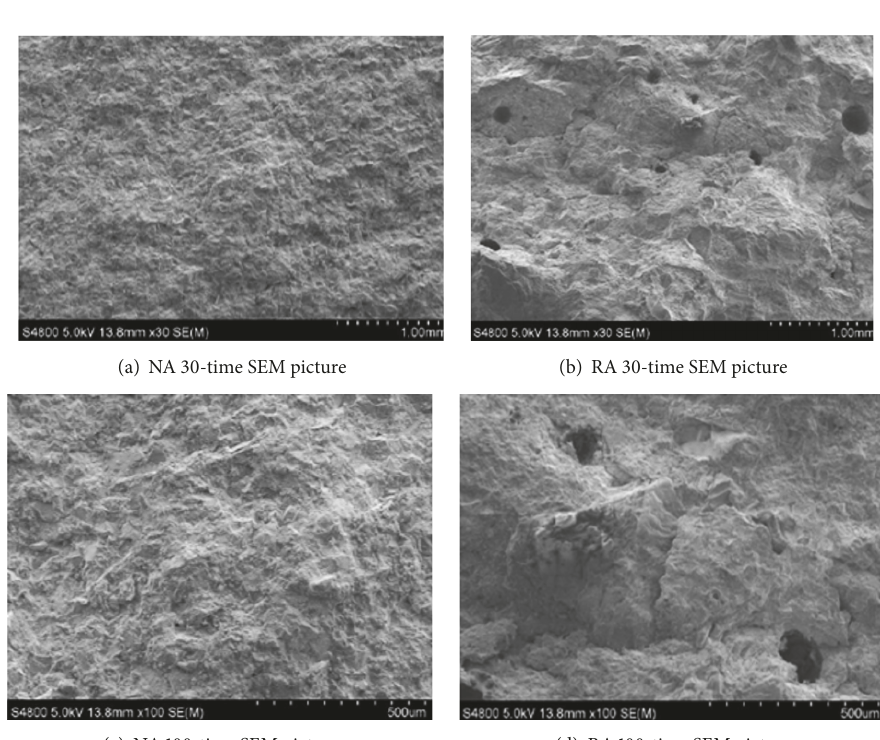
Figure 3: RA/NA SEM